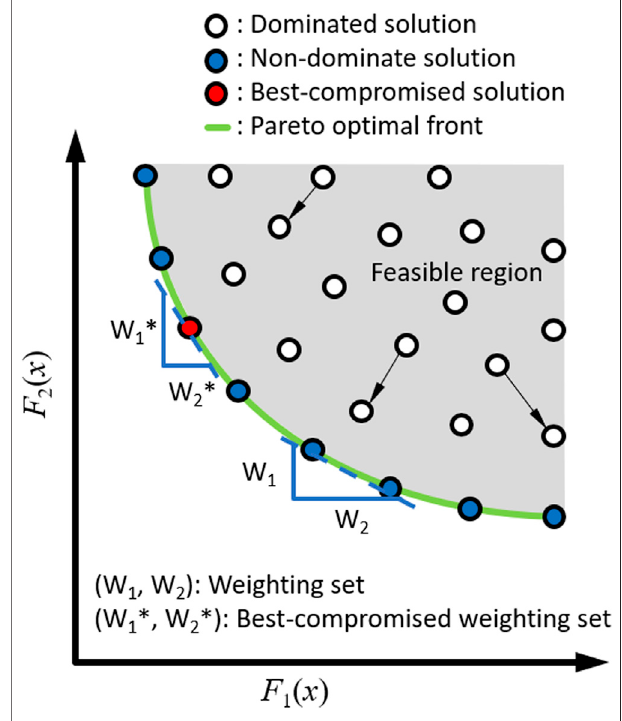
FIGURE 1 | Feasible region, non-dominated (Pareto) solutions (green line) and the best-compromise solution (red circle) of a two-objective optimization problem of a single design variable x in the objective function domain [ F 1 ( x ), F 2 ( x )]. Within the feasible region, solutions are called dominated (e.g., white circles) if both objective functions can be improved simultaneously. In contrast, a solution is called non-dominated ( fi lled circles) if none of the objective functions can be improved without degrading the other objective function values. All nondominated solutions are considered equally good unless a single nondominated solution called best-compromise solution is chosen according to the utility function, which de fi nes the decision maker ’ s preference structure in terms of weightings associated with the objective functions (W 1 and W 2 ). The best-compromise weighting set (W 1 * and W 2 *) identi fi es the best-compromise solution that maximizes the decision maker ’ s utility function among the non-dominated